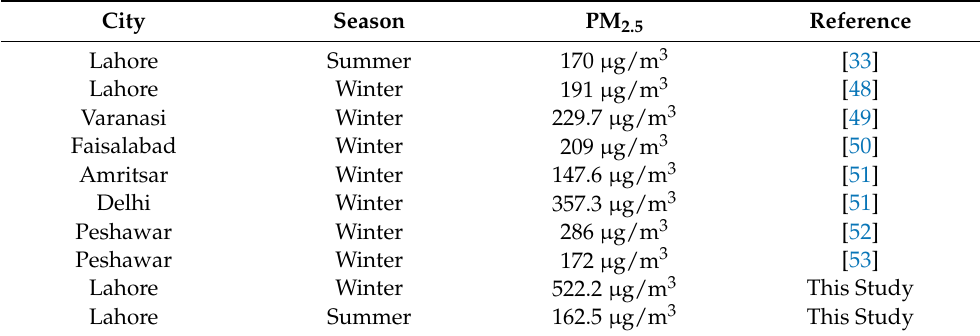
Table 2. Comparison of PM 2.5 mass concentration ( µ g/m 3 ) of the present study with other studies conducted in Megacities of Pakistan and